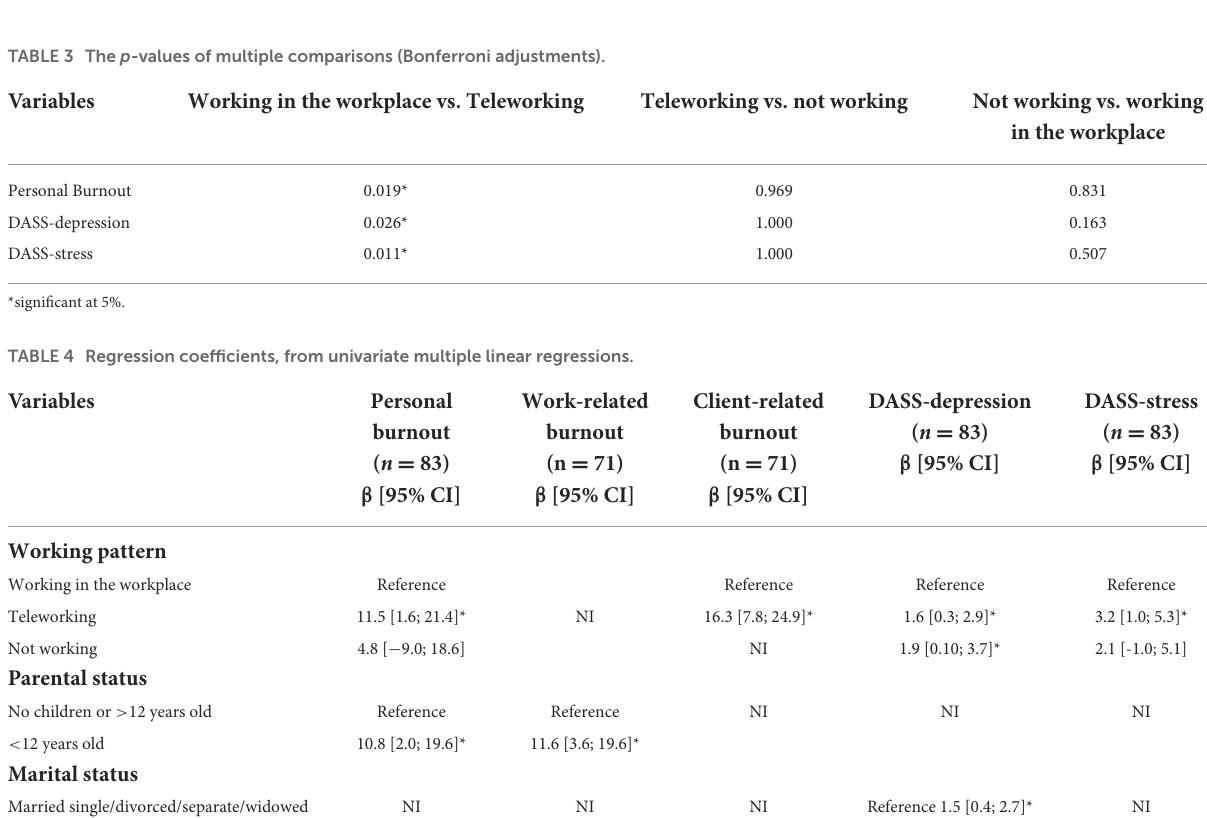
TABLE 3 The p -values of multiple comparisons (Bonferroni adjustments).